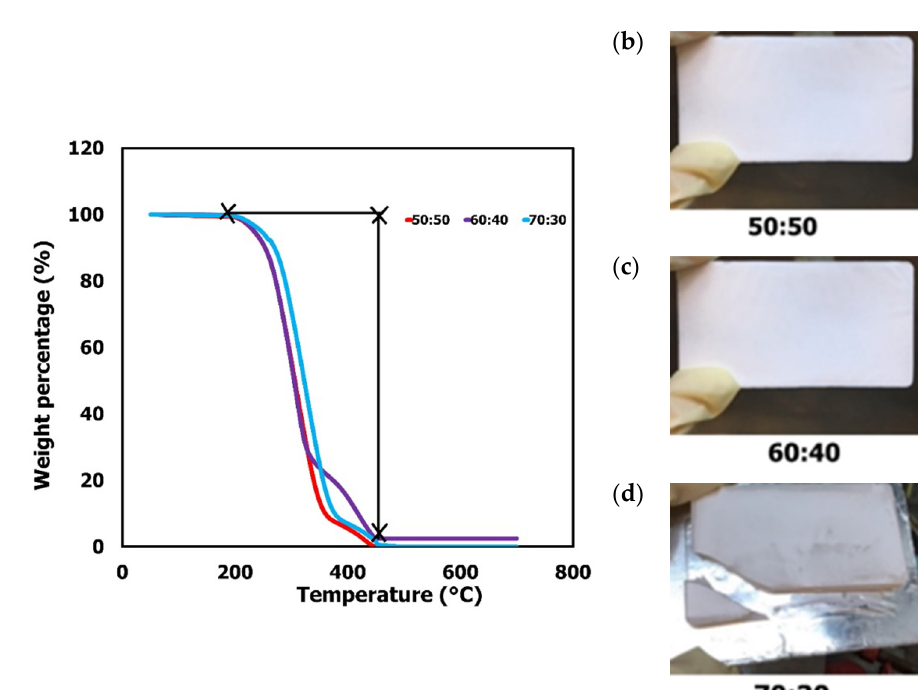
Figure 7. TGA analysis of microsphere-templated monolith at temperatures ranging from 50 °C to 700 °C ( a ) and the physical structure of the monoliths prepared at 50:50 ( b ), 60:40 ( c ), and 70:30 ( d ) ratio.